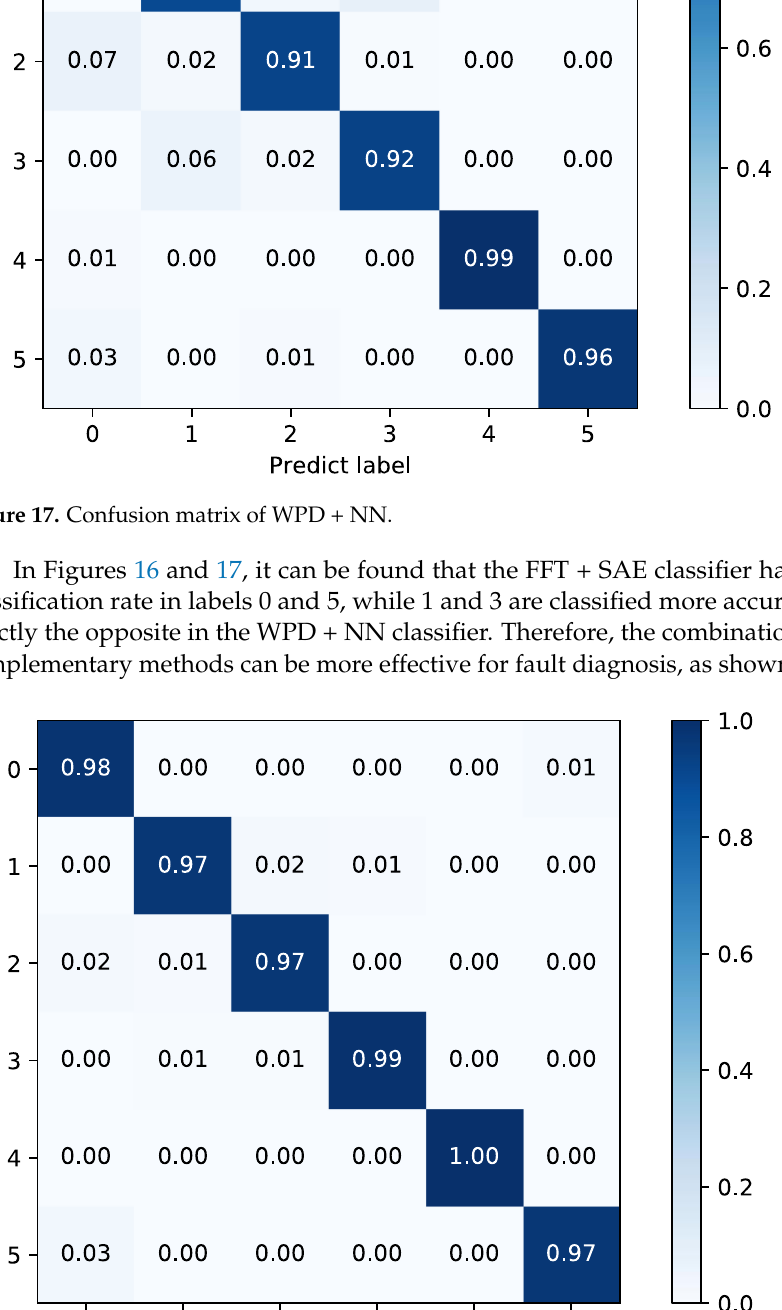
Figure 18. Confusion matrix of the fusion model.